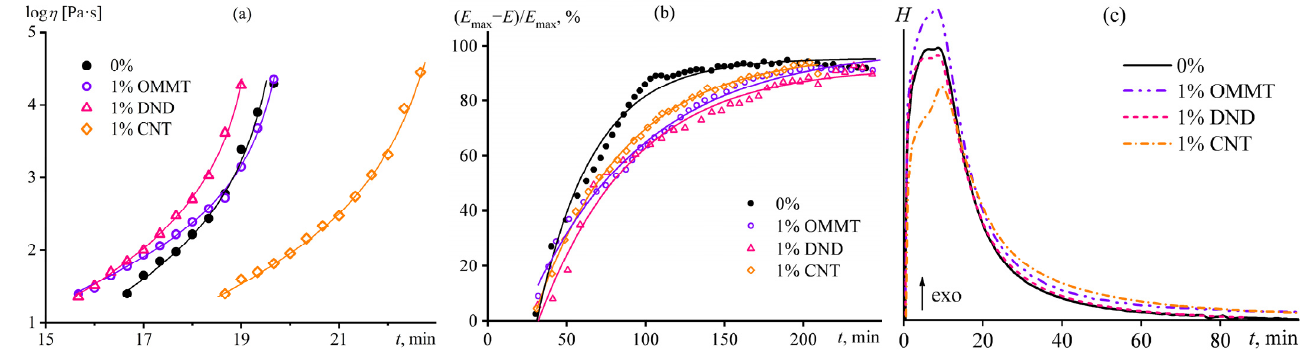
Figure 10. Time dependences of viscosity ( a ), reduced complex modulus ( b ), and heat release ( c ) for epoxy binder ( a , c ) and carbon fiber prepreg ( b ) in the curing process at 180 °C.